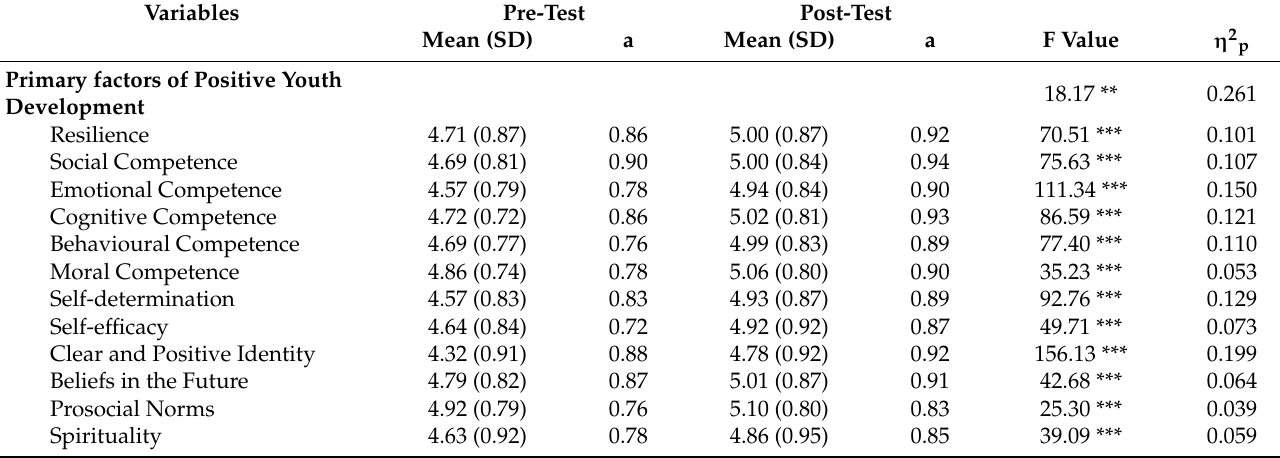
Table 2. Results of one-way repeated measures MANOVA (Students’ change between pre- and post-test) ( n =